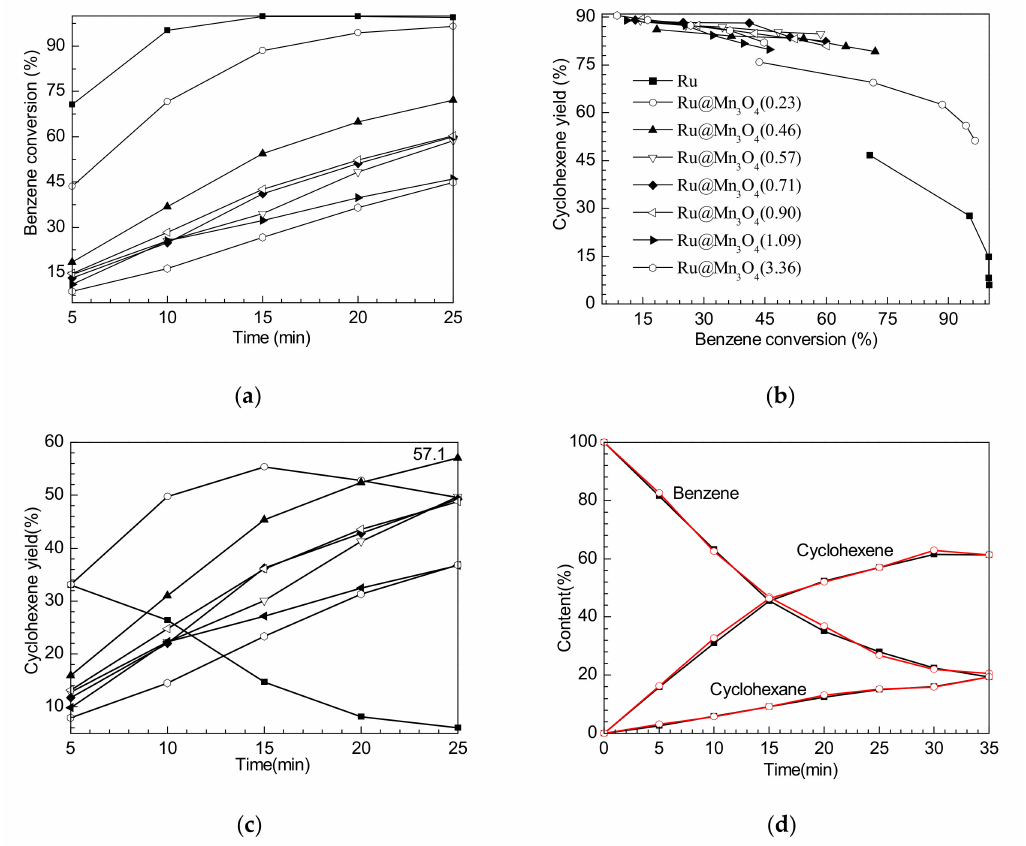
Figure 3. Catalytic activity towards cyclohexene formation from selective hydrogenation of benzene over Ru@Mn 3 O 4 ( x ) catalyst in the presence of ZnSO 4 with the di ff erent molar ratio of Mn to Ru as well as the kinetic curve over Ru@Mn 3 O 4 (0.46) ( m cat = 1.8 g, c ZnSO4 = 0.57 mol L − 1 , v H2O = 280 mL, v benzene = 140 mL, T = 423 K, p H2 = 5.0 MPa). ( a ): Benzene conversion; ( b ): cyclohexene